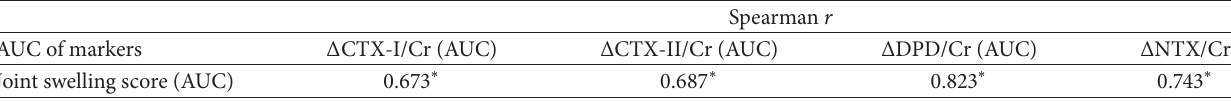
Correlation coefficients are shown. ∗ 𝑃 < 0.05 (Spearman rank correlation); CTX-I, C-telopeptide fragment of type I collagen; CTX-II, C-telopeptide fragment of type II collagen; DPD, deoxypyridinoline; NTX, N-telopeptide fragment of type I collagen; Cr, creatinine; AUC, area under the concentration/score-versus- time